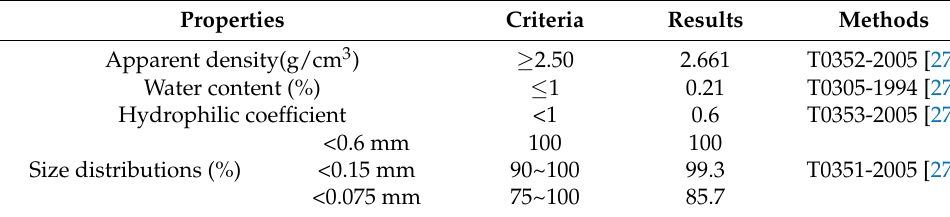
Table 5. Mineral filler